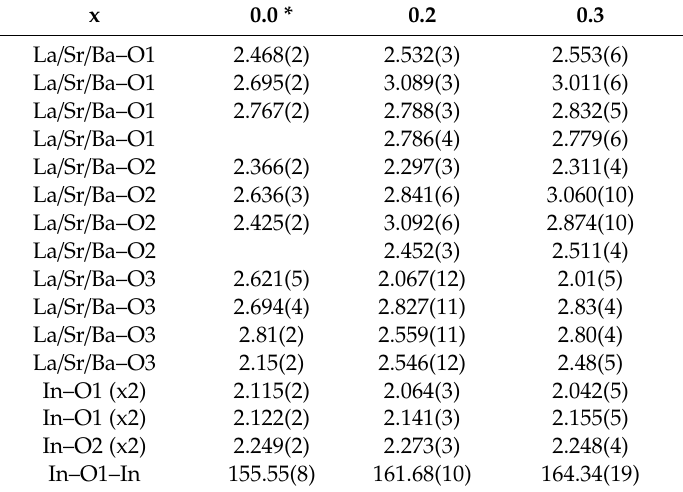
Table 4. Main interatomic distances (Å) and angles ( ◦ ) for La 1 + x Sr 1 − x In 4 + δ (x = 0.0, 0.2, and 0.3) determined from NPD data at